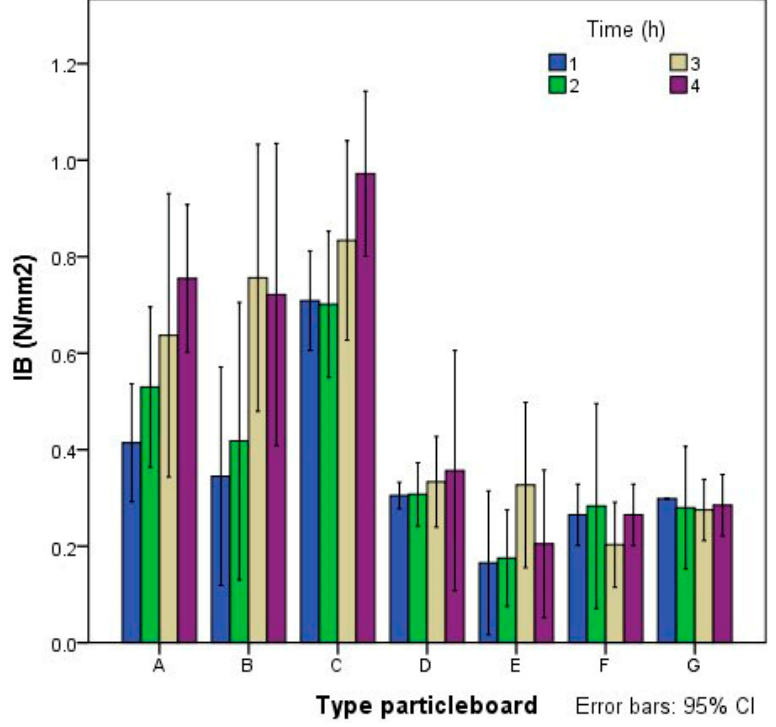
Figure 6. Internal bounding strength.